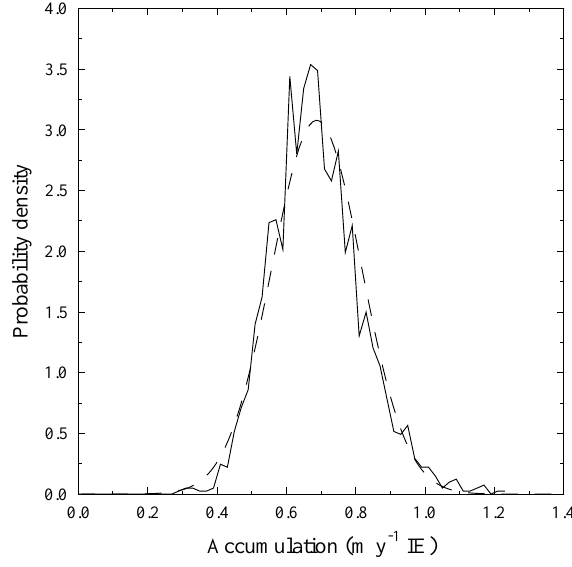
Figure 8. Probability density function for the power-law-based an- nual snow accumulation rate (solid line) and the equivalent normal distribution (dashed line). Note excess accumulation in the right hand tail of the power-law